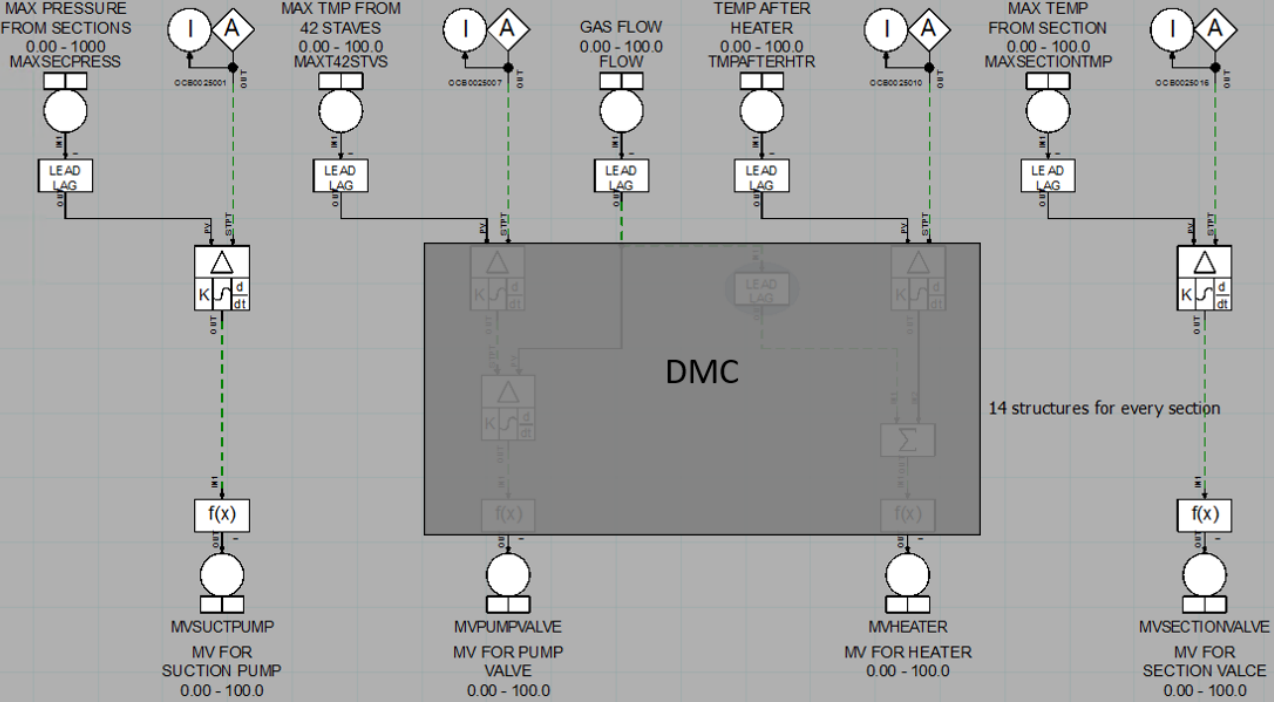
Figure 8. The thermal system: the advanced structure version